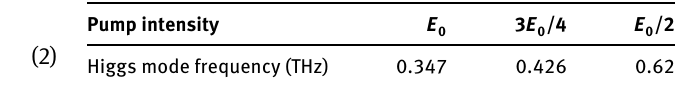
Figure 4: Mode switching dynamics and Higgs amplitude mode excitation under THz pump. (a) Measured temporal evolution of Δ E = under different pump THz field strength ( t = 7.0 ps), corresponding to the purple dashed lines marked (open circles) as a function of t pp gate in Figure 3(a). The fitting curves are represented by solid lines. (b) Measured normalized THz transmission spectra for different t /2 (each curve is offset vertically by 0.2). (c) Measured transmission change relative to the transmission coefficient pump field strength is E 0 = 0 s at 0.32, 0.61, and 0.5 THz as a function of t when the pump field strength is E /2. at t pp pp 0